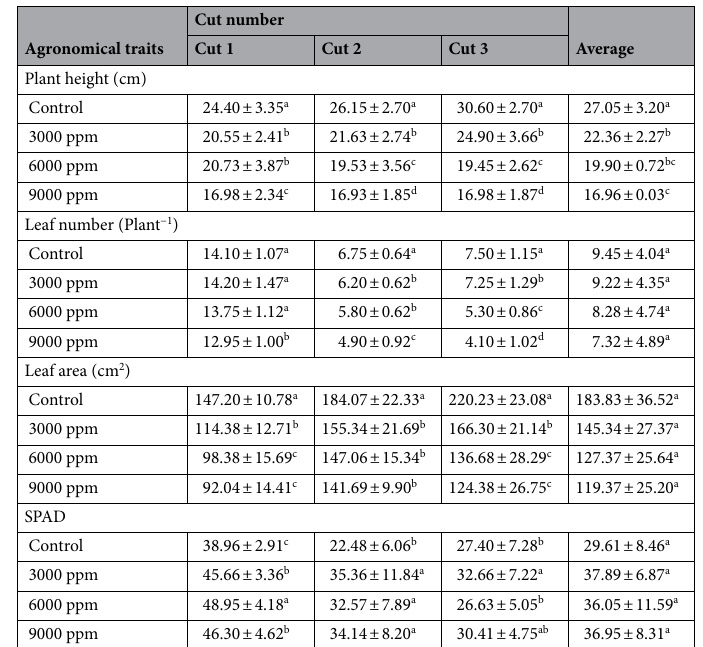
Table 5. Plant height, leaf number, leaf area and SPAD values of kale cultivated under freshwater and different salinities (3000 ppm, 6000 ppm, and 9000 ppm) at different cuts. Data expressed as mean ± SD (n = 5). Means in the same column at the same cutting time point having different lower superscript letters are significantly different at p <